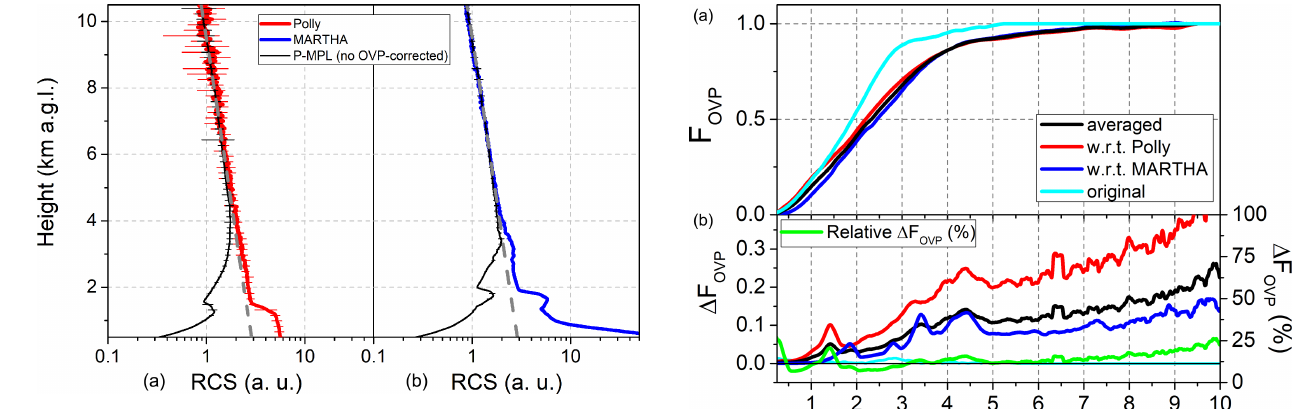
Figure 1. Comparison of the normalized reference (a) Polly (red line; for clarity, the 12 P-MPL and Polly RCS profiles from 28 June 18:00UT to 29 June 05:00UT were averaged) and (b) MARTHA (blue line; 4 P-MPL and MARTHA RCS profiles from 23 July 21:00UT to 24 July 00:00UT were averaged) with respect to the uncorrected by overlap P-MPL profiles (black lines). Normalization height at 9.5kma.g.l. The aerosol-free background signal is shown by a grey dashed line.